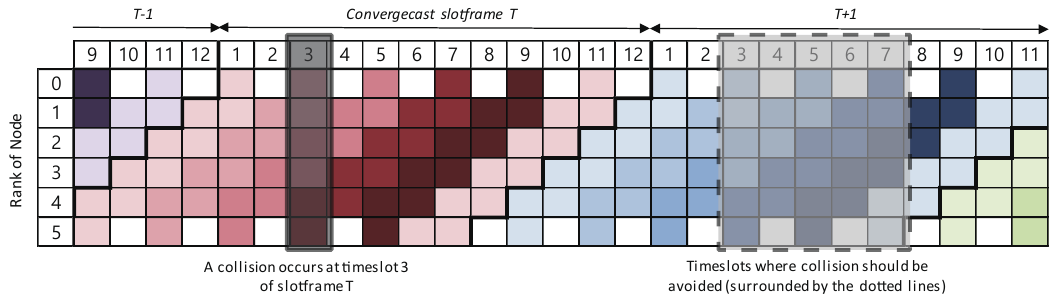
Figure 6. Timeslots of the convergecast slotframe where collisions should be